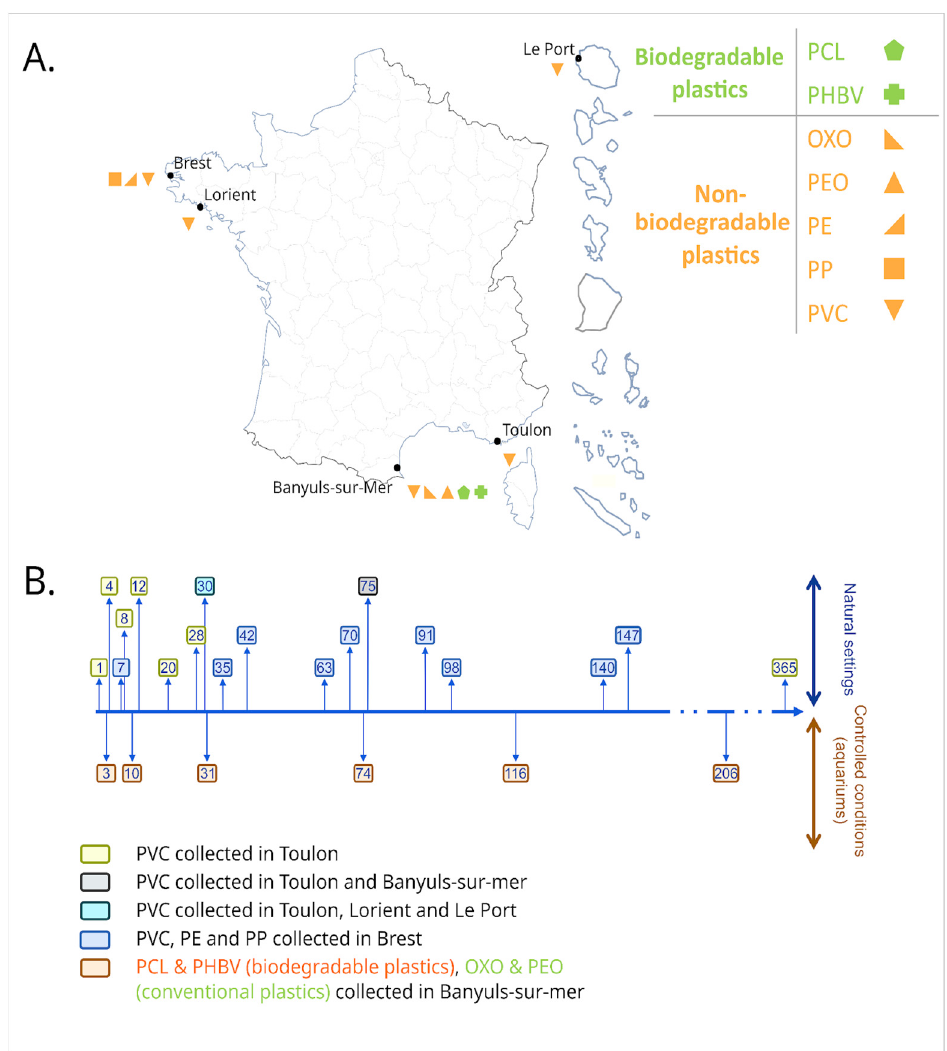
Figure 1. ( A ) Map of France and French territories presenting the sampling locations and the studied plastic types. ( B ) Timeline representing incubation times (days) for the di ff erent studied